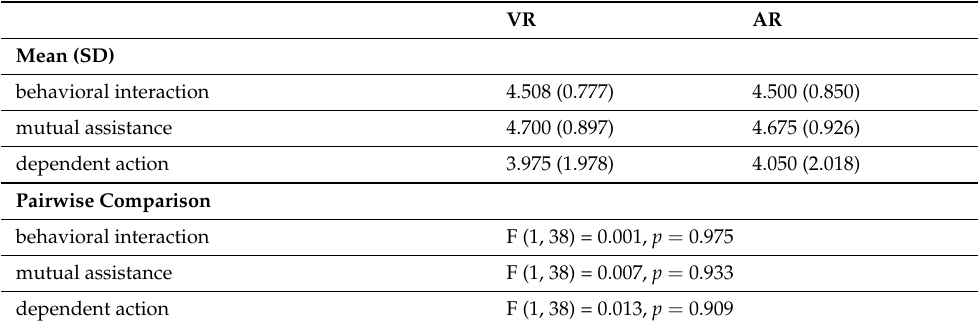
Table 3. Analysis results of social presence via the interactions between users in the asymmetric experiment environment (DAVE).